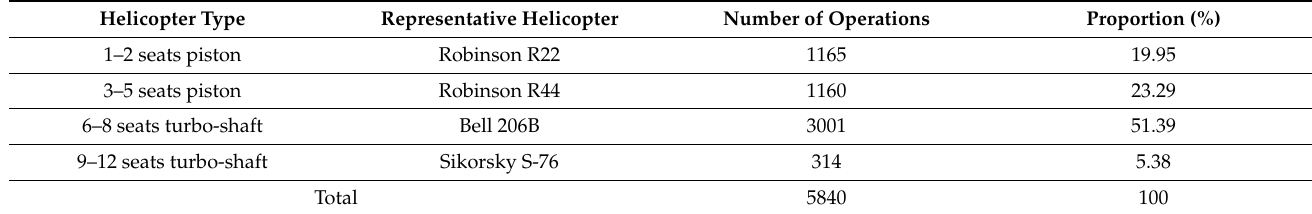
Table 8. Fleet composition of helicopters by